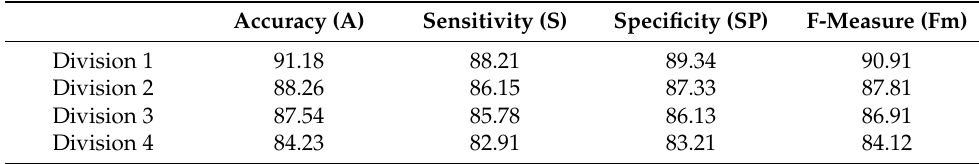
Table 2. Performance metrics of the proposed